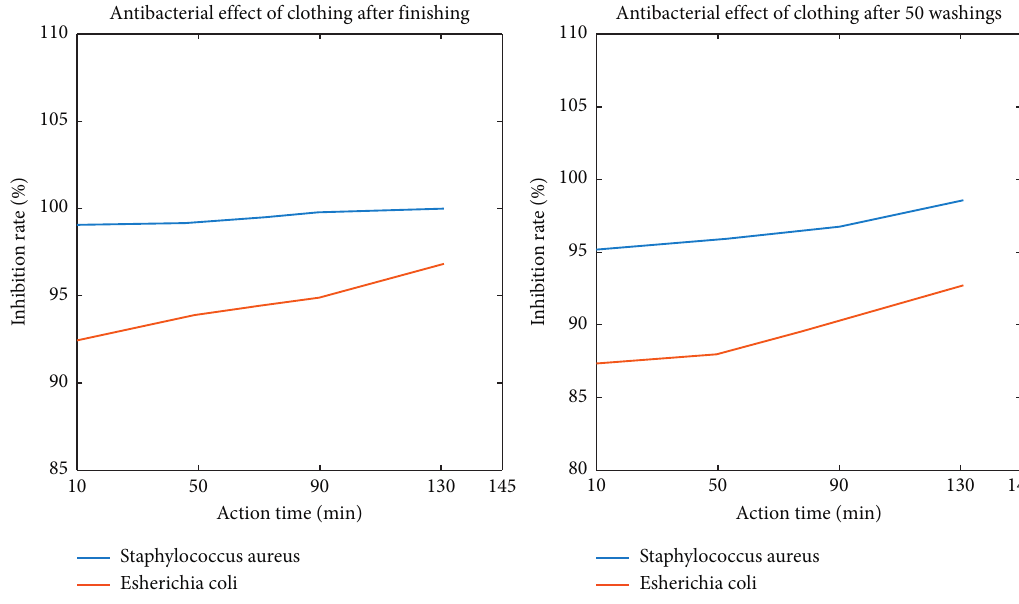
Figure 7: Nano-antimite and antibacterial knitted